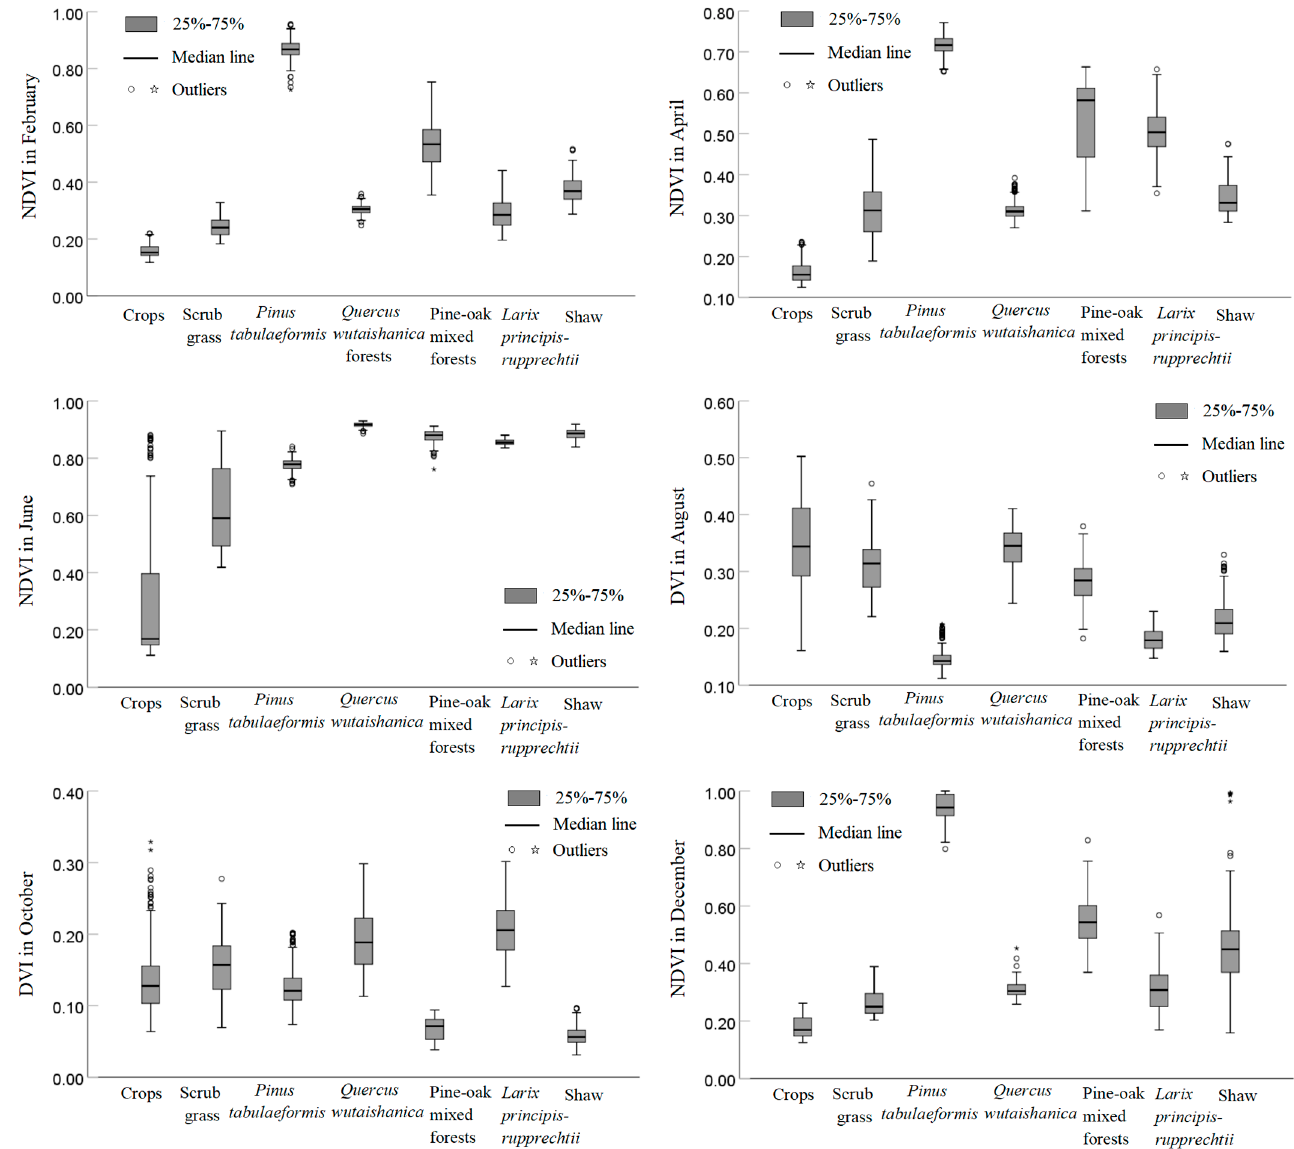
Figure 5. Box plot of typical vegetation